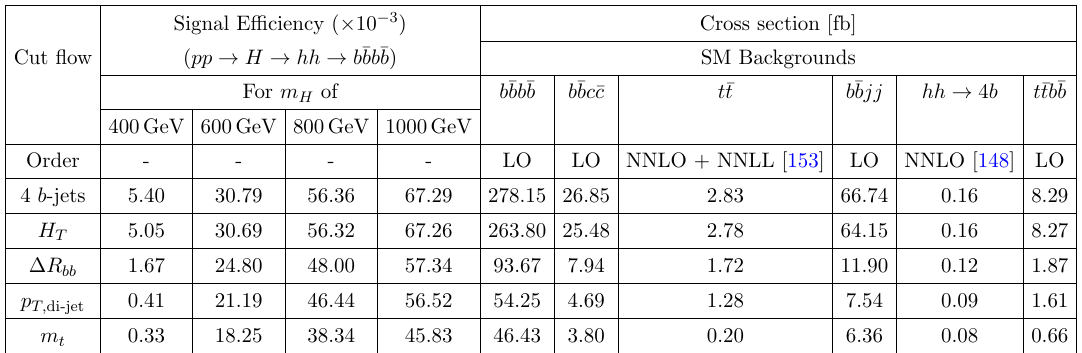
Table 8 . Cut-(cid:13)ow table before performing the multivariate analysis, in the b (cid:22) bb (cid:22) b channel.